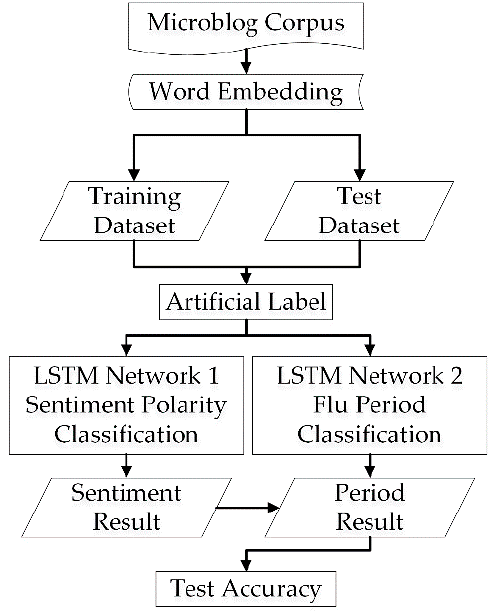
Figure 9. Process of Flu Period and Sentiment Classification.